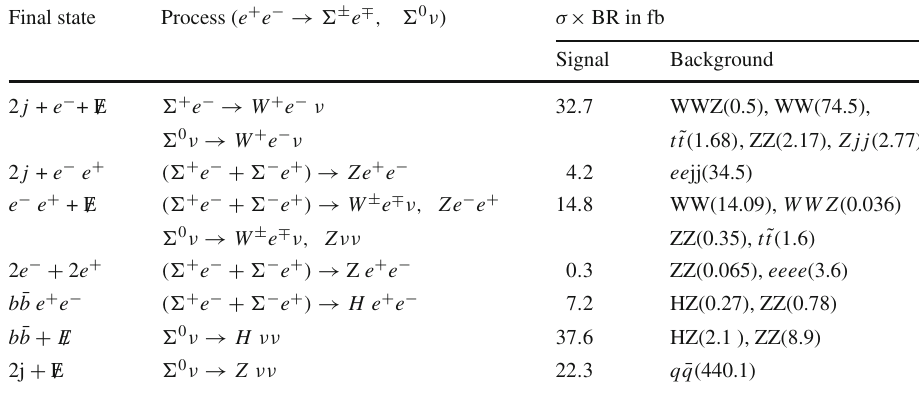
Table 3 Fiducial cross sections of signal and SM backgrounds corresponding to different final states arising from the process e − e + → (cid:2) ± e ∓ and e + e − → (cid:2) 0 ν , with p T ( j ) ≥ 20 GeV, p T ((cid:4)) ≥ 10 GeV, and pseudo-rapidity | η | ≤ 2 . 5 for jets and leptons. Centre-of-mass √ s = 1 TeV and energy of M (cid:2) = 500 GeV are considered with the assumed mixing of